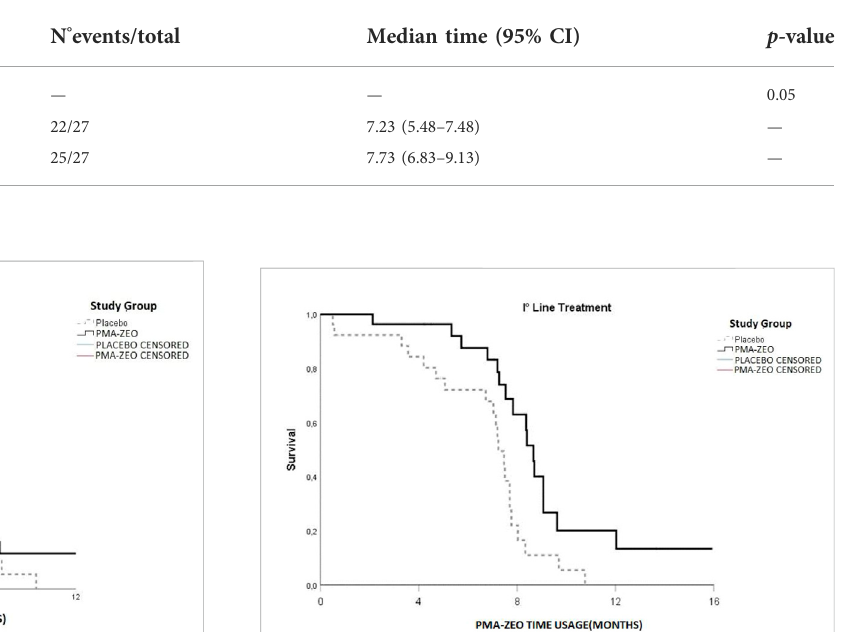
FIGURE 5 Overall survival (OS) at the PMA-ZEO 7-month time point for death events strati fi ed by I ° line treatment